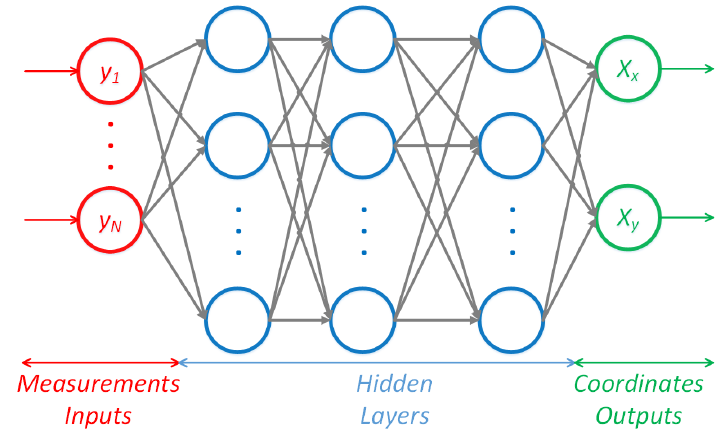
Figure 2. Proposed Deep Feed-Forward Neural